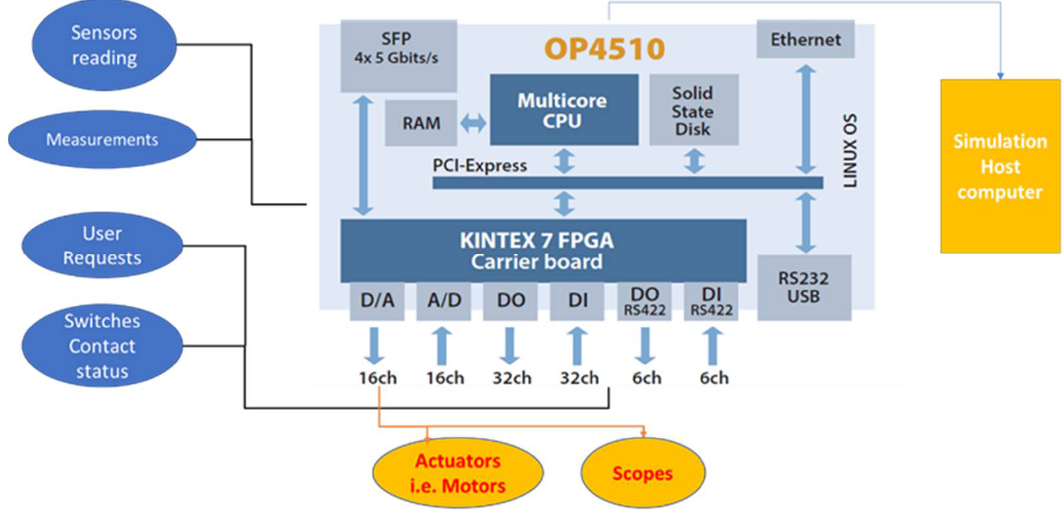
Figure 7. Real-time co-simulation for microgrid applications.